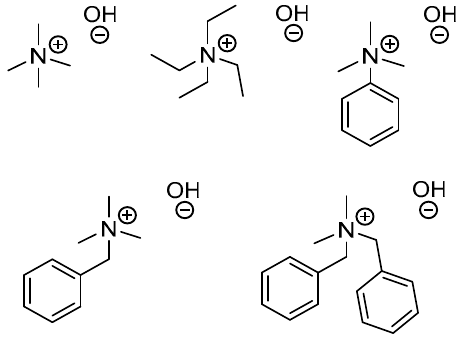
Figure 1. Top: from Lilienfeld’s 1924 patented electrolytes for cellulose dissolution [48,49]; bottom: the first commercially available ammonium hydroxides for cellulose dissolution, known as Triton B (left) and Triton F (right) [51].